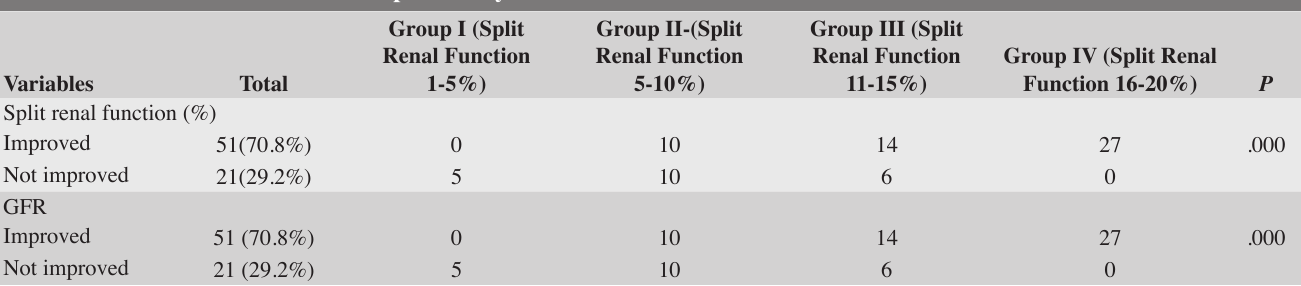
Table 2. Effects of Percutaneous Nephrostomy